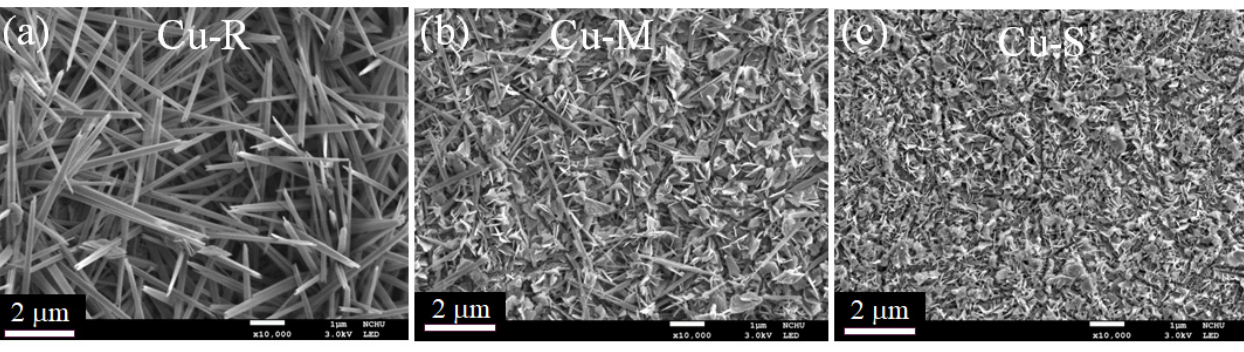
Figure 1. FESEM images of ( a ) Cu-R, ( b ) Cu-M, and ( c ) Cu-S.